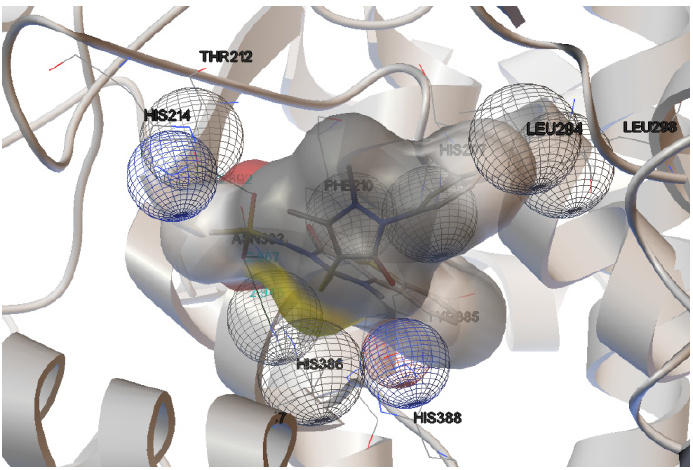
Figure 4. Binding of 4 into the active site of COX–2.